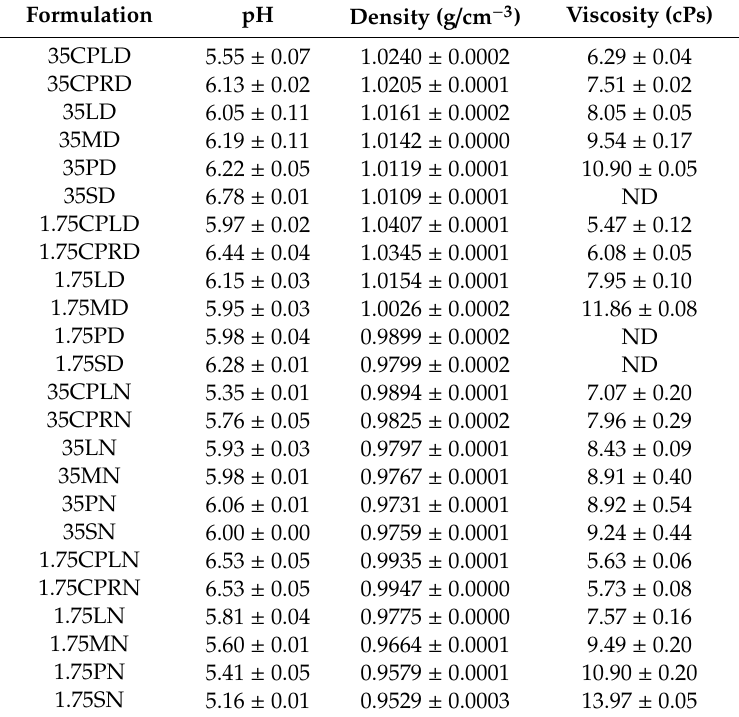
Table 2. Physical properties of fatty acid-based in situ forming matrix (triplicate testing; n =